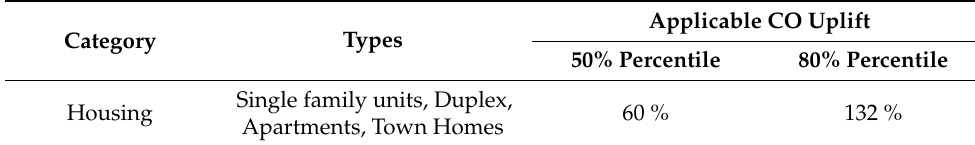
Table 3. Applicable capital expenditure uplifts for the 50% and 80% percentile.